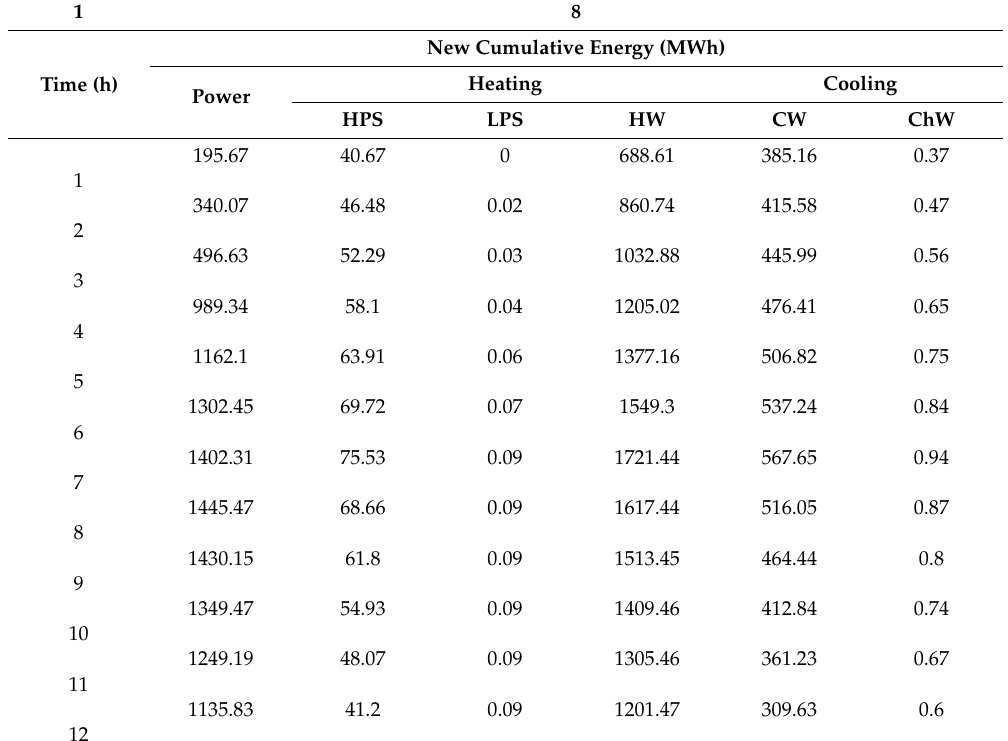
Table A15. TriGenSCA after iteration from 1 to 12 h.